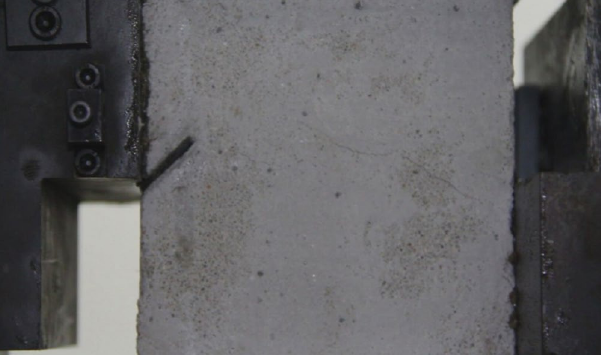
Figure 43. Photograph of a specimen showing fractures appearing in the middle of the specimen.